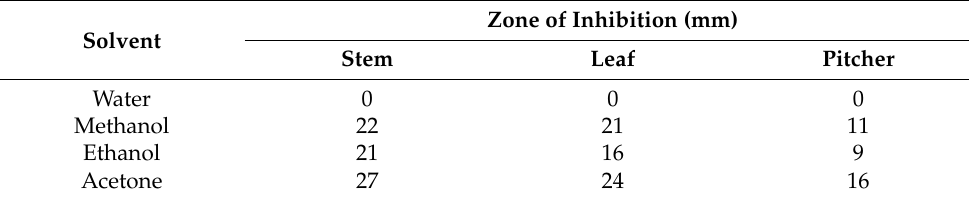
Table 2. Inhibition zone of N. miranda extracts.